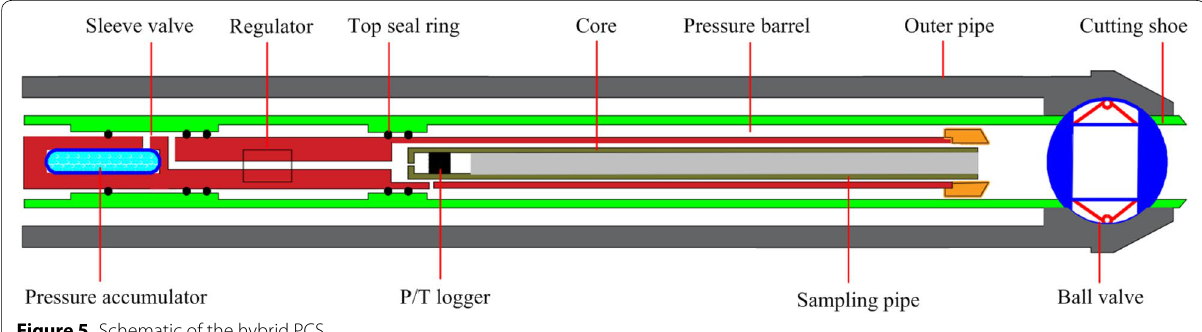
Figure 5 Schematic of the hybrid PCS